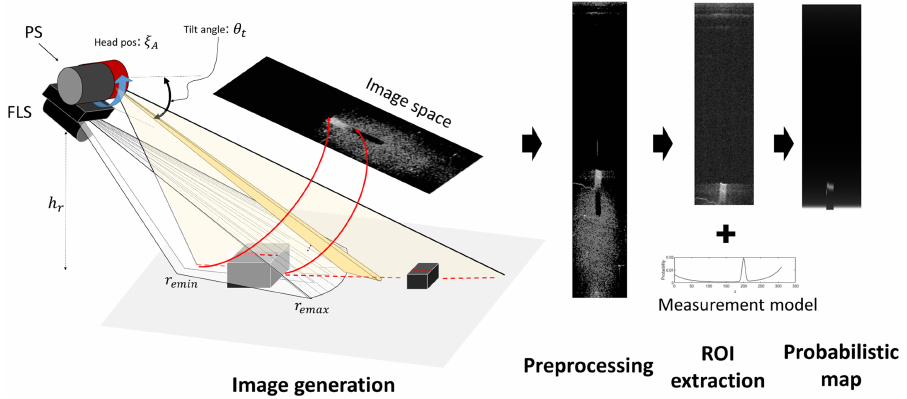
Figure 6. FLS measurement